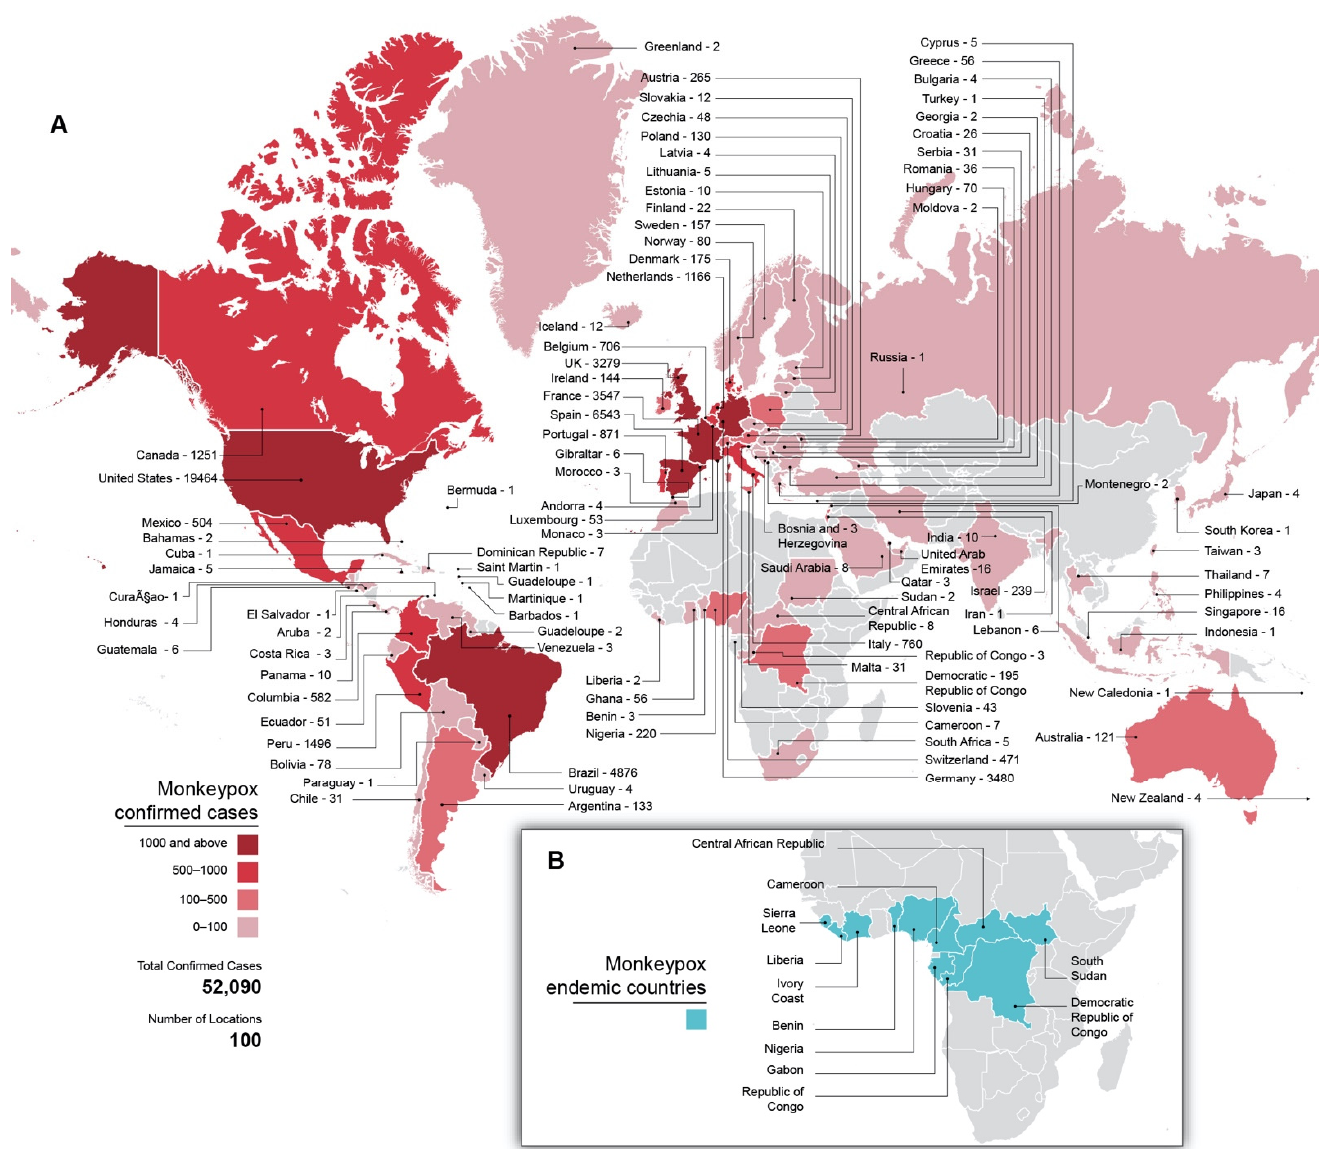
Figure 1. Global distribution of MPX cases. ( A ) MPX cases per country in the current outbreak through 1 September 2022 as well as total confirmed cases and affected countries. Countries are colored according to case counts. Gray shading indicates no known cases. ( B ) Countries historically endemic for MPXV. Gray shading indicates non-endemic countries.